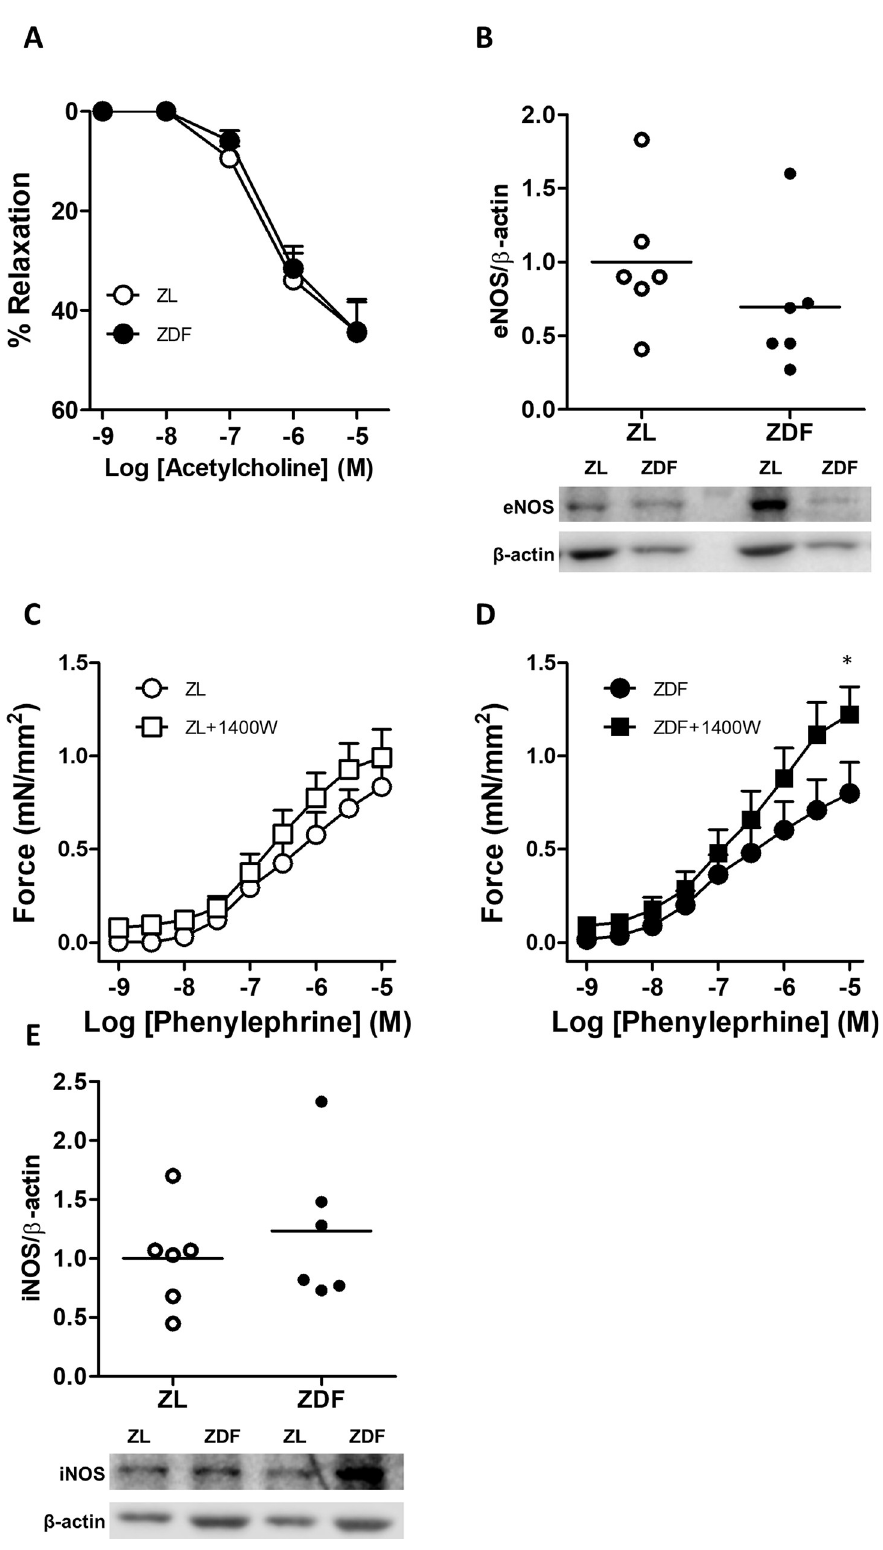
Fig 5. ZDF rats show normal PA pulmonary artery endothelial function and eNOS expression but iNOS inhibition unmasks vasoconstrictor hyperresponsiveness in ZDF rats. (A) Cumulative concentration-response